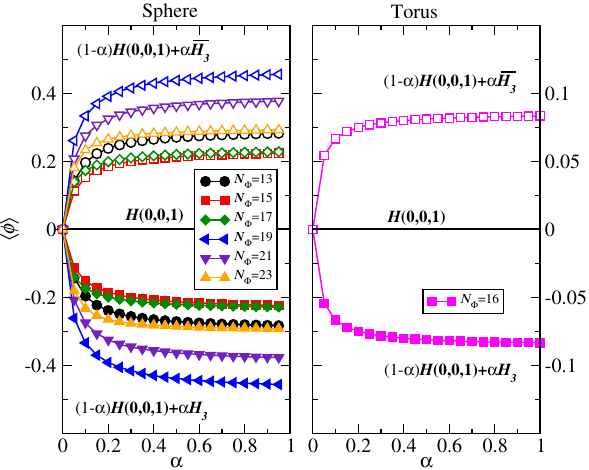
FIG. 17. Three-body energy contributions are calculated with system-size-dependent (bottom panel) and extrapolated FIG. 16. Left: The particle-hole-antisymmetric order para- (top panel) spherical pseudopotentials. The energy differences meter computed for Hamiltonians in the spherical geometry between the extrapolated values are 0 . 000066 e 2 = ϵ l 0 ¼ that interpolate between the N ¼ 1 Landau-level Coulomb 0 . 045 κ j V ð 3 Þ j (bottom panel) and 0 . 00019 e 2 = ϵ l ¼ 0 . 13 κ j V ð 3 Þ j Hamiltonian H ð 0 ; 0 ; 1 Þ at α ¼ 0 and the Hamiltonians H 3 (solid 0 3 3 symbols) and H 3 (open symbols), respectively, for systems with (top panel). Although relatively small, these values are per N ¼ 13 – 21 corresponding to N ¼ 7 – 11 . Right: The same but particle and should thus provide extensive energy separation Φ e between the two states in the thermodynamic computed on the torus using a rectangular unit cell for N e ¼ 8 .